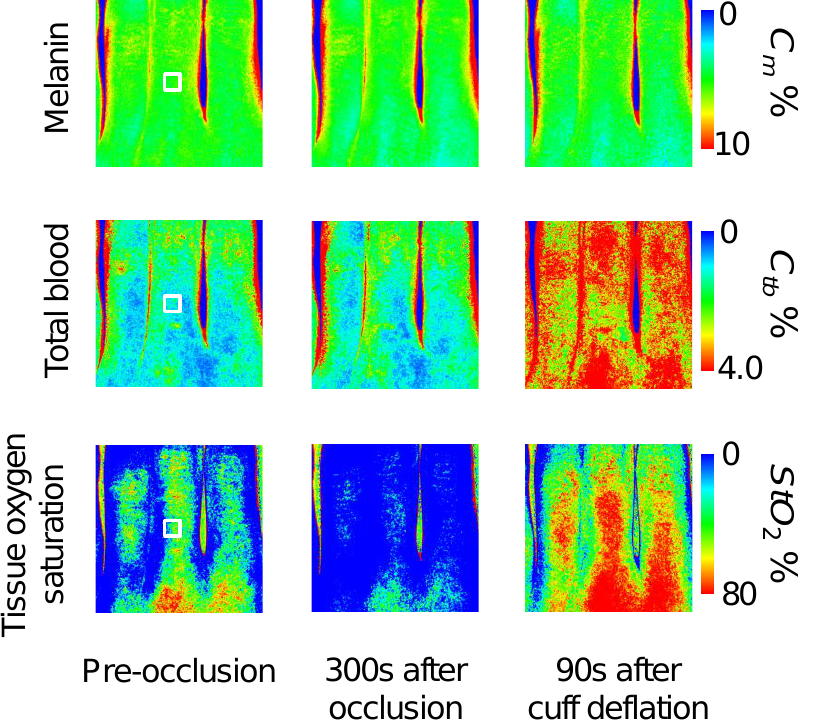
Figure 7. Typical images of fingers (from top to bottom; C pre-occlusion, 300 s after occlusion, and 90 s after deflation of pressure